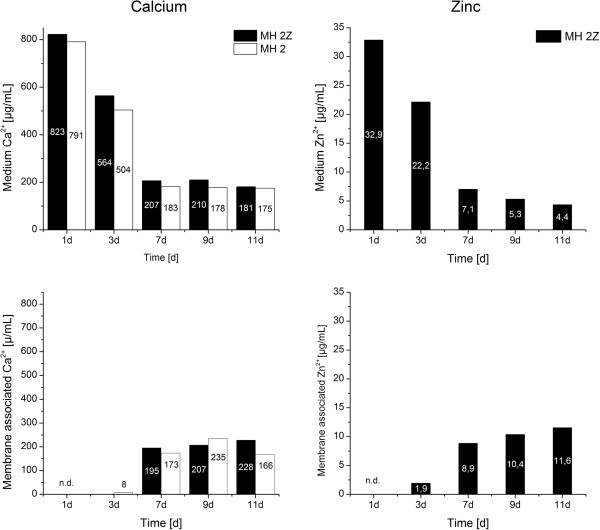
Calcium and zinc concentrations were determined in media and membrane associated by ICP-OES. Halomonas halophila were cultivated in MH 2 and MH 2Z medium. Samples at 1, 3, 7, 9, and 11 days were analyzed. Black columns: MH 2Z medium, white columns: MH 2 medium. Concentrations of calcium and zinc are indicated in the columns in μg/mL. The concentration of membrane associated calcium at day 1 was not determined (n.d.) due to cell density limitations.